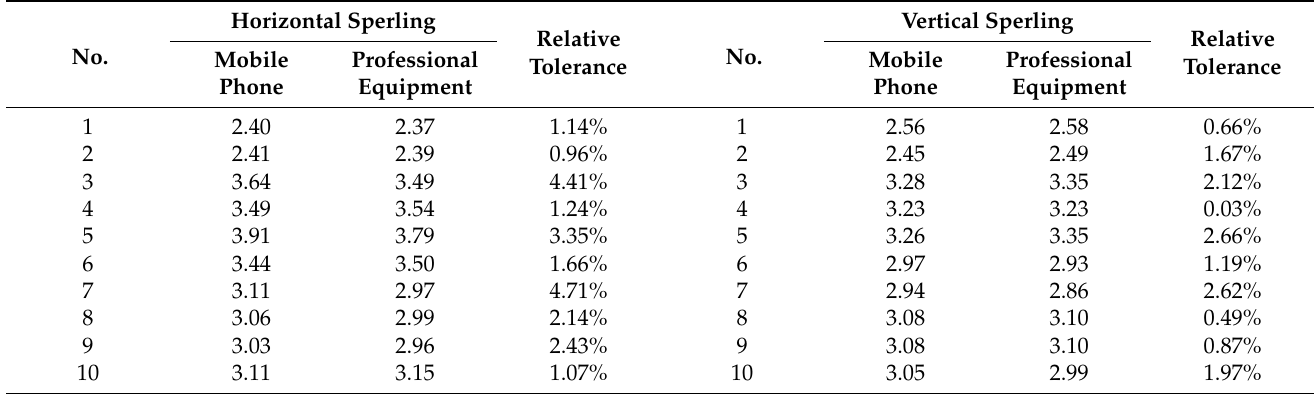
Table 2. Comparison of Sperling index values of mobile phone/professional